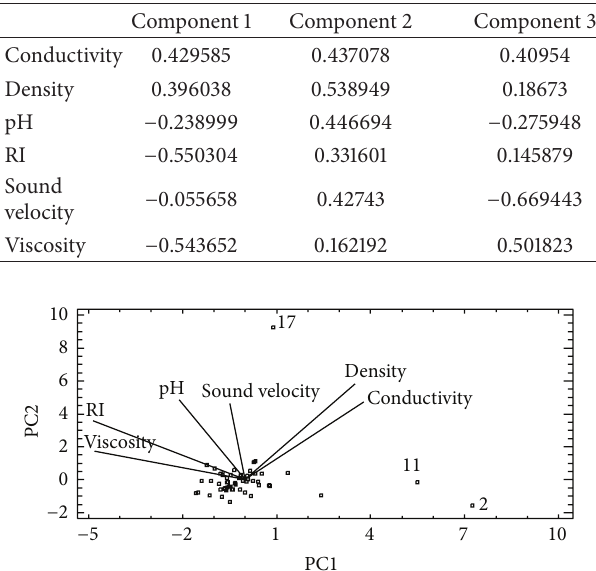
Table 3: Table of weights of the main components.